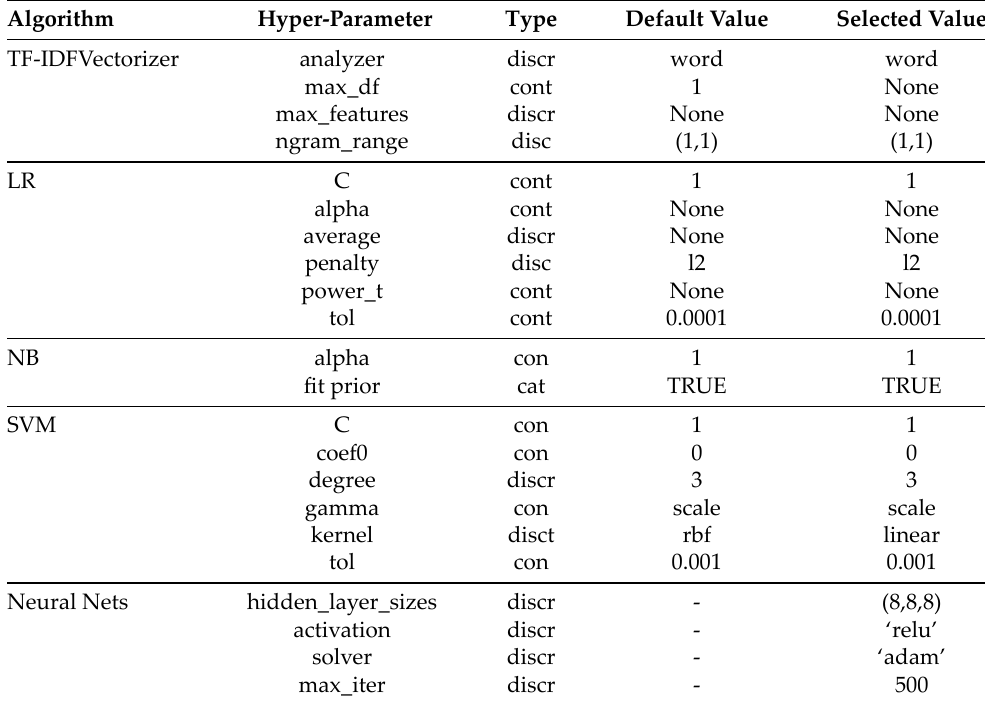
Table 4. Hyper-parameters values of the machine learning and the TF-IDF